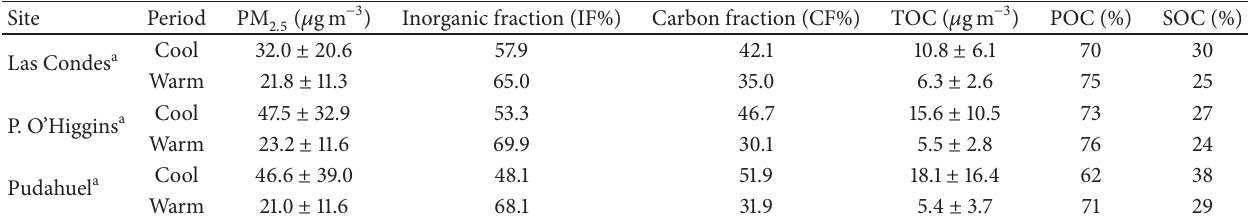
Table 6: Average inorganic and organic fractions (as percentages), total carbon (TC) incorporated into the PM 2.5 , and organic (OC) and elemental carbon (EC) fractions as percentages of the total carbon (TC) in the period from 2002 to 2007 at the three stations studied in the cool and warm